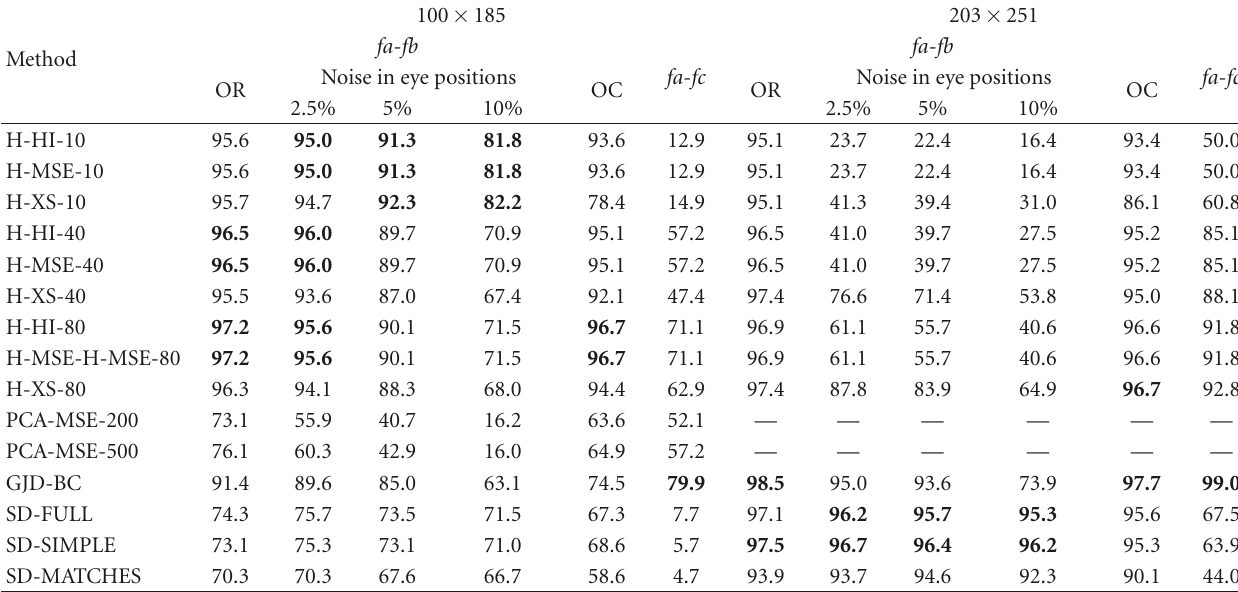
Table 1: FERET fa-fb and fa-fc tests. Top-1 recognition rate. Noise in eye positions and face occlusion is tested in the fa-fb test. OR: Original. OC: Original plus Occlusion. The best results for each condition are presented in bold. Methods that have di ff